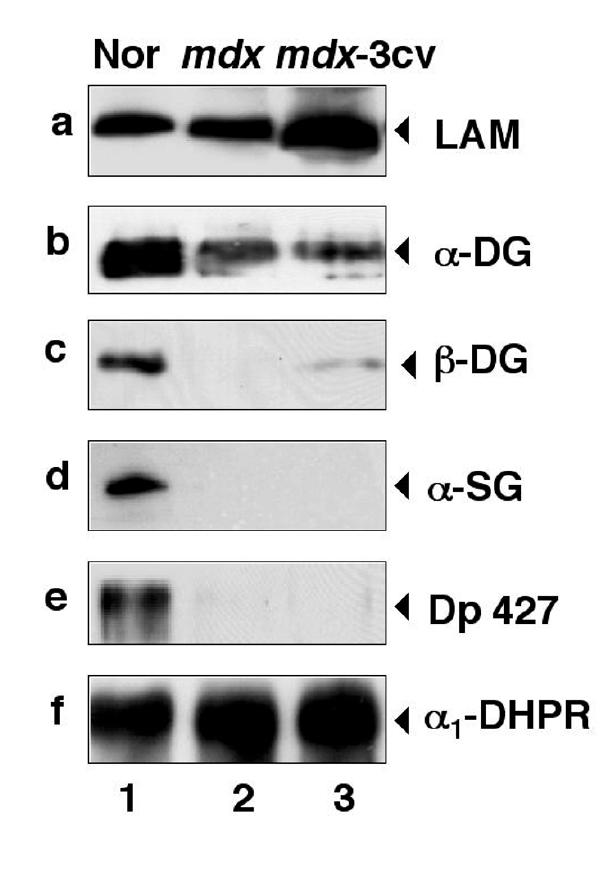
Figure 5 Immunoblot analysis of β -dystroglycan and associ- ated components in normal and dystrophic skeletal muscle fibres. Shown are identical immunoblots labeled with antibodies to laminin (LAM) (a), α -dystroglycan ( α -DG) (b), β -dystroglycan ( β - DG) (c), α -sarcoglycan ( α -SG) (d), full-length dystrophin of apparent 427 kDa (Dp427) (e), and the α 1 -subunit of the dihydropyridine receptor ( α 1 -DHPR) (f). Lanes 1 to 3 represent microsomal membranes isolated from normal muscle fibres, mdx fibres, and mdx -3cv fibres, respectively. The position of immuno-decorated protein bands is indicated by arrow